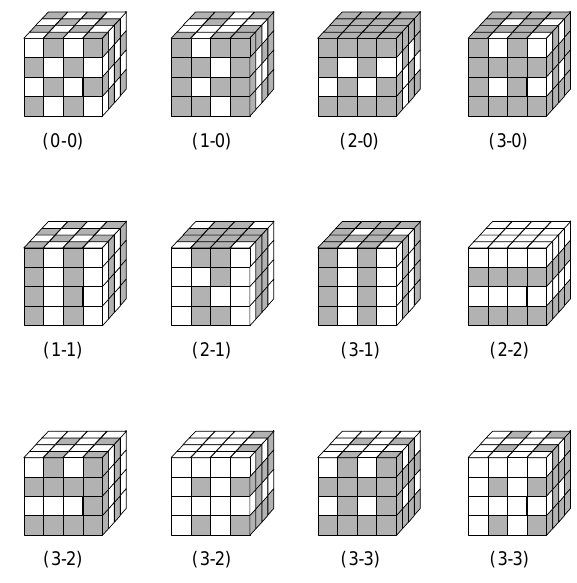
Classification of two-phase composite. (From Newnham, Skinner and